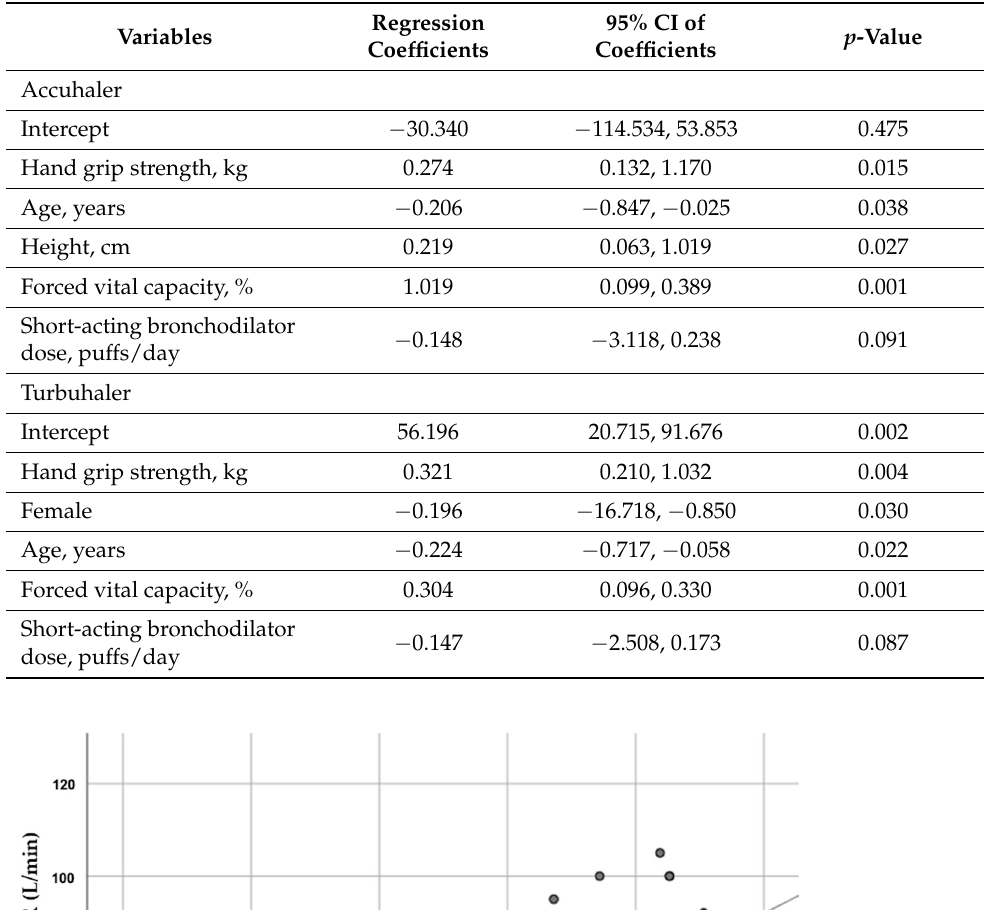
Table 4. Linear regression analysis for peak inspiratory flow rate and hand grip strength adjusted by age, gender, height, forced vital capacity, and short-acting bronchodilator dose.